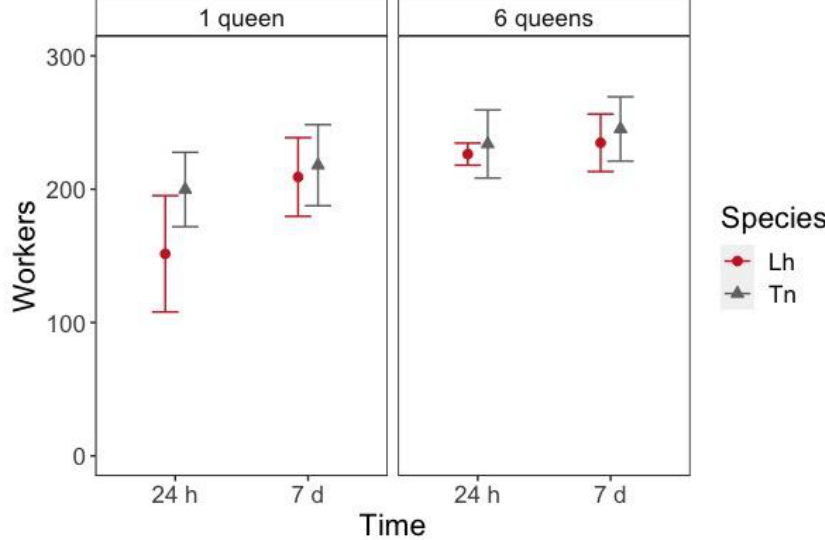
Figure 3. Number of workers (mean ± 95% Confidence Interval (CI)) inside the nest 24 h and 7 days after placing them in the foraging arena according to the species (Lh = L. humile and Tn = T. nigerrimum ) and the number of queens in the